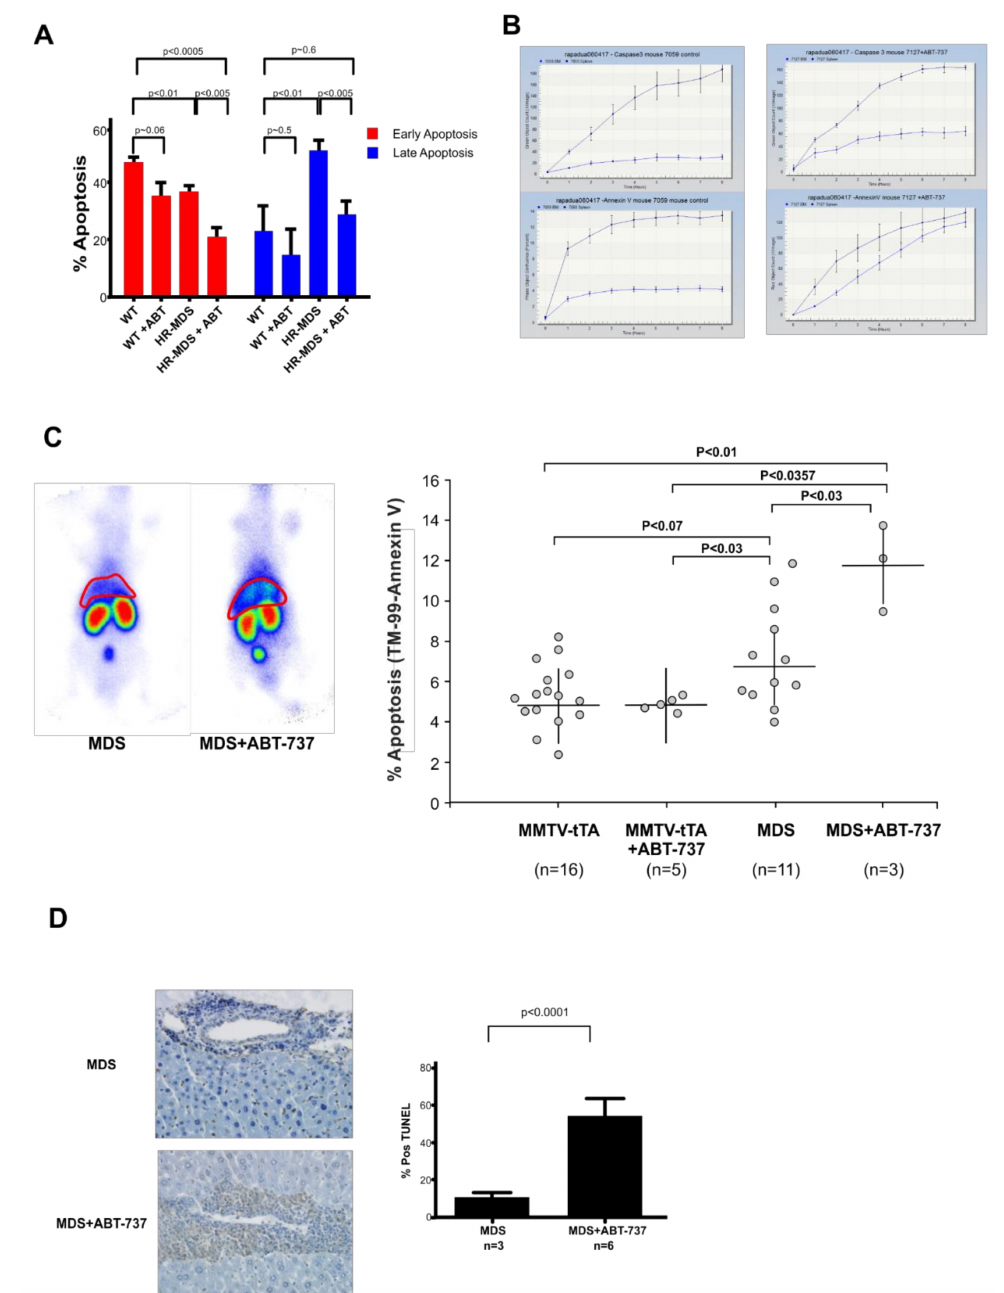
Figure 2. ABT-737 treatment of HR-MDS cells reduced apoptosis of BM cells and induces apoptosis in the liver and spleen of HR-MDS mice. ( A ) Histogram of mean ± SD showing a decrease of early and late apoptotic cells ( n = 3); ( B ) Representative incucyte profiles of normal healthy untreated normal and HR-MDS treated mice showing reduced BM and increased spleen apoptosis; ( C ) Paired untreated and treated radioisotope heat maps of 99m Tc labeled annexin-V, which targets apoptotic cells and is metabolized by kidneys and bladder, shows greater intensity around the localization of the liver in the treated HR-MDS mouse. Dot plot showing increase of 99m Tc labeled annexin-V uptake in liver of the treated HR-MDS mice ( n = 3) compared to untreated HR-MDS mice ( n = 11), p < 0.03, compared to treated single transgenic mice ( n = 5), p ≈ 0.03, and compared to untreated single transgenic mice ( n = 16), p < 0.01 after 23 days of treatment. Untreated HR-MDS mice show an increase of 99m Tc labeled annexin-V uptake compared to treated single transgenic mice, p < 0.03; ( D ) Representative DNA fragmentation as demonstrated by TUNEL-positive myeloid cells is significantly greater in the liver of treated HR-MDS mice ( n = 6) compared to untreated HR-MDS mice ( n = 3) after 33 days of treatment, p < 0.0001. The nuclei of the hepatocytes are staining in blue and the brown staining apoptotic cells are in the sinusoid